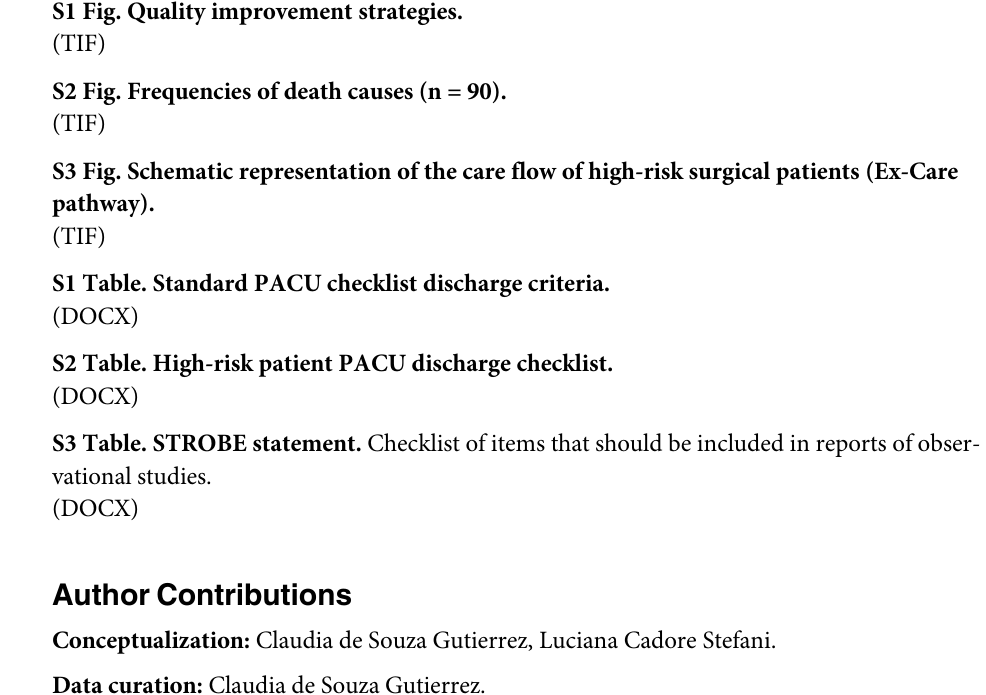
S1 Fig. Quality improvement strategies. S2 Fig. Frequencies of death causes (n = 90). S3 Fig. Schematic representation of the care flow of high-risk surgical patients (Ex-Care pathway). S1 Table. Standard PACU checklist discharge criteria. S2 Table. High-risk patient PACU discharge checklist. S3 Table. STROBE statement. Checklist of items that should be included in reports of obser- vational